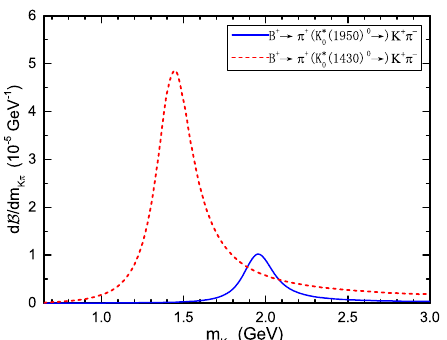
Figure 2 . Di(cid:11)erential branching fractions from threshold of K(cid:25) pair to 3 GeV for the B + ! K (cid:3) (1430) 0 (cid:25) + ! K + (cid:25) (cid:0) (cid:25) + and B + ! K (cid:3) 0